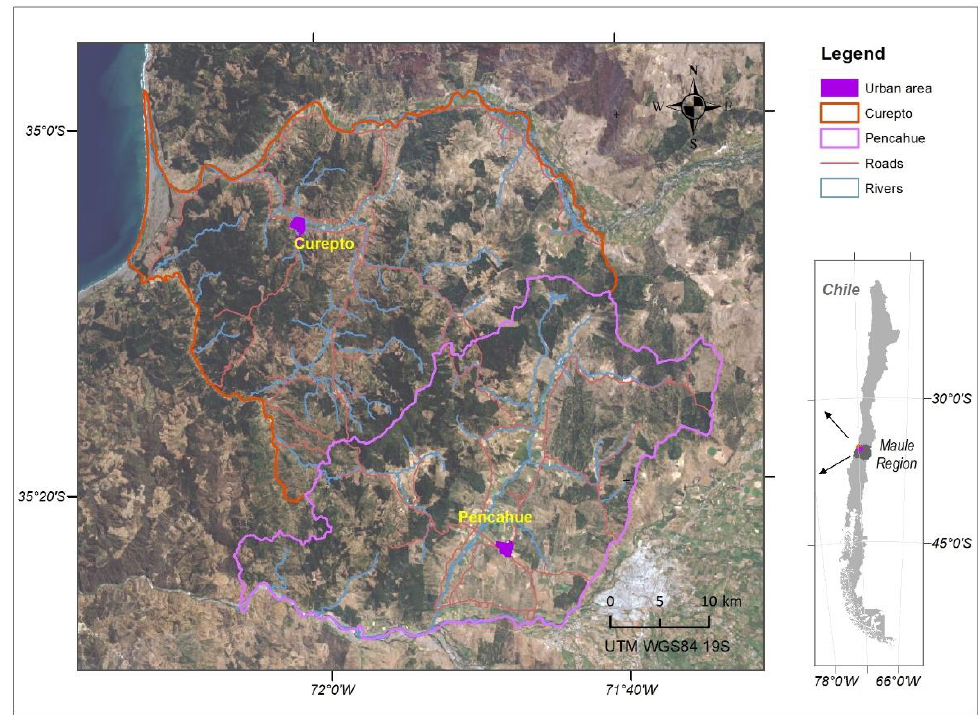
Figure 1. Localization of the study area in